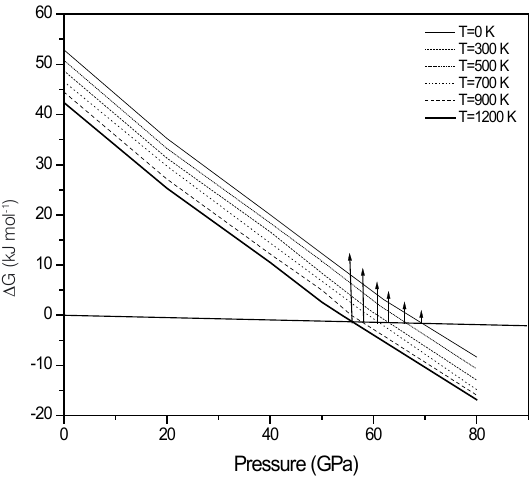
Figure 1. Variation of Δ G (kJ mol -1 ) with pressure for CaO at different